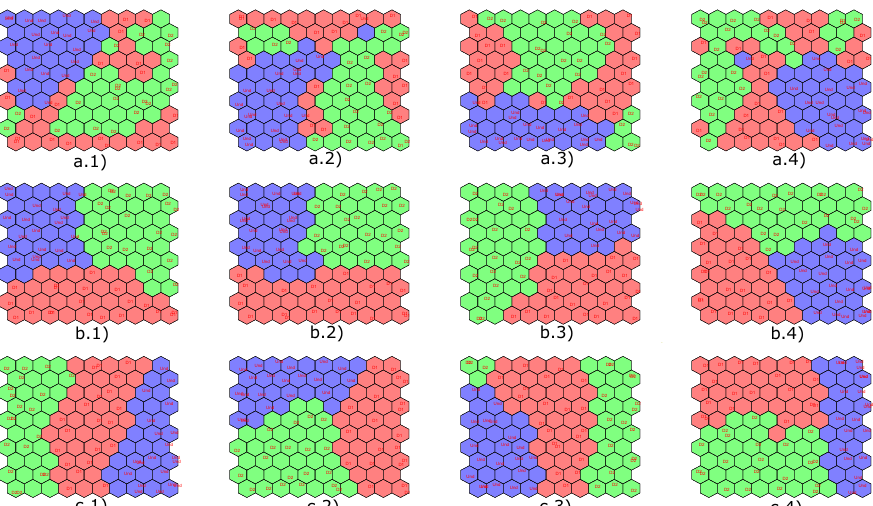
Figure 19. Results obtained by implementing the CPANN ( a ), SKN ( b ) and XYF ( c ) networks for: 2 principal components (group 1), 4 principal components (group 2), 6 principal components (group 3) and 8 principal components (group